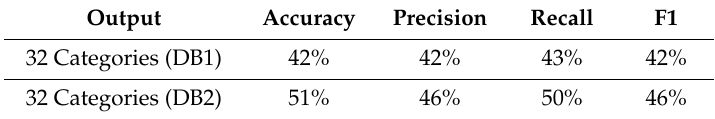
Table 7. Results for category classification on Pinterest images from two